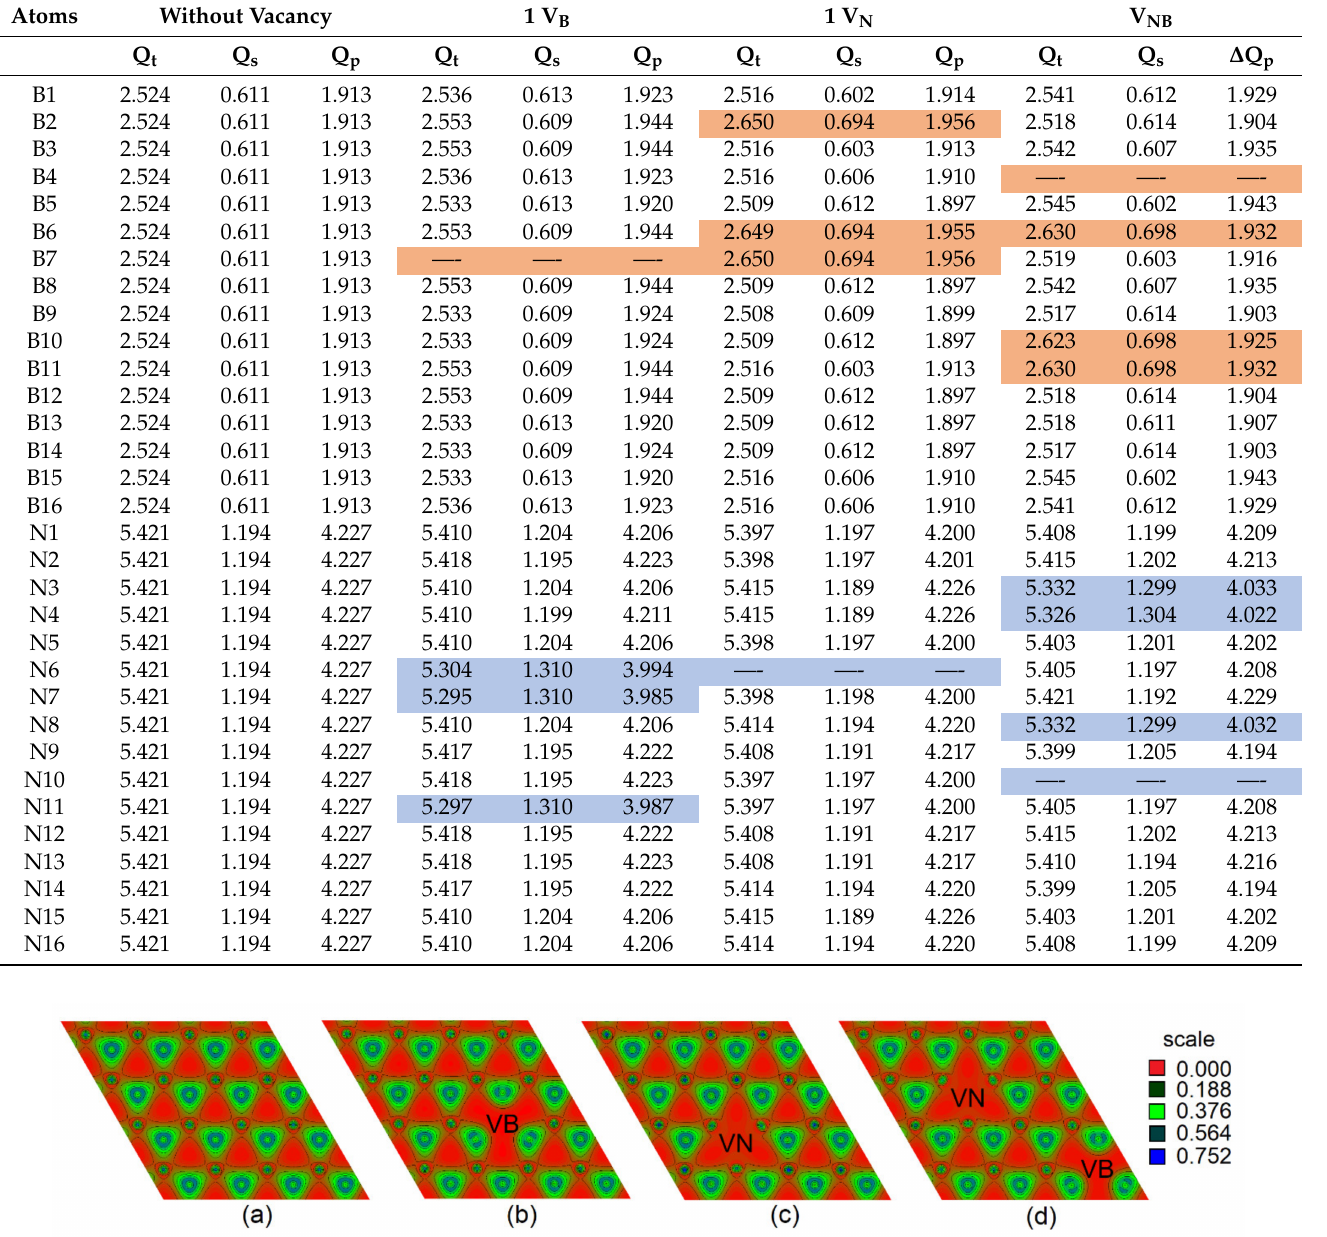
Electronic charge per Löwdin orbital (measured in units of electrons e/Bohr 3 ) h- BN/graphene heterobilayer with vacancy and without 1 V B , 1 V N , and V BN , where Q t is total